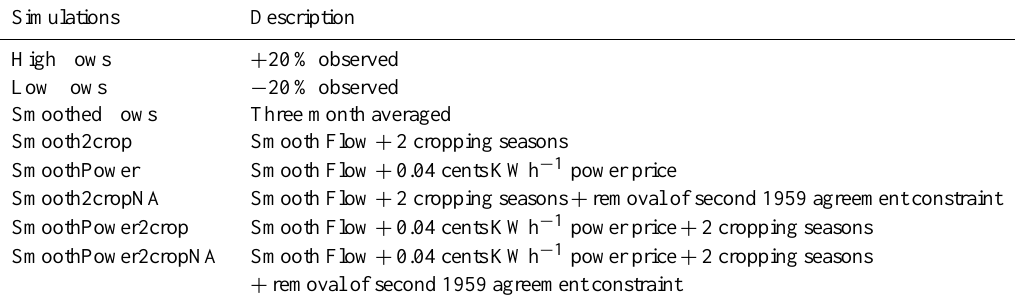
Table 4. Description of the simulations used in